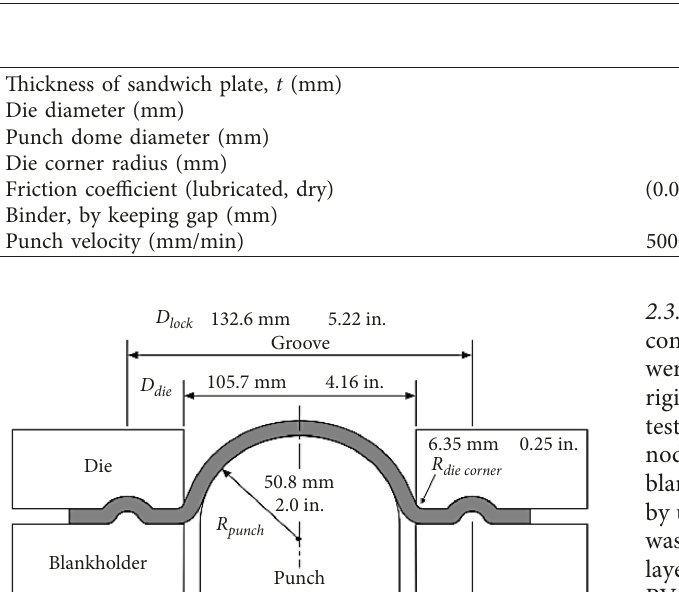
Table 2: Input process parameters and geometrical specifications.